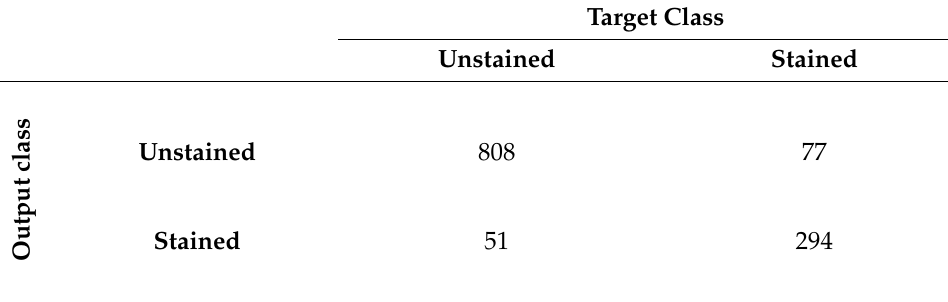
Table 4. Confusion matrix for the bottom-view camera.